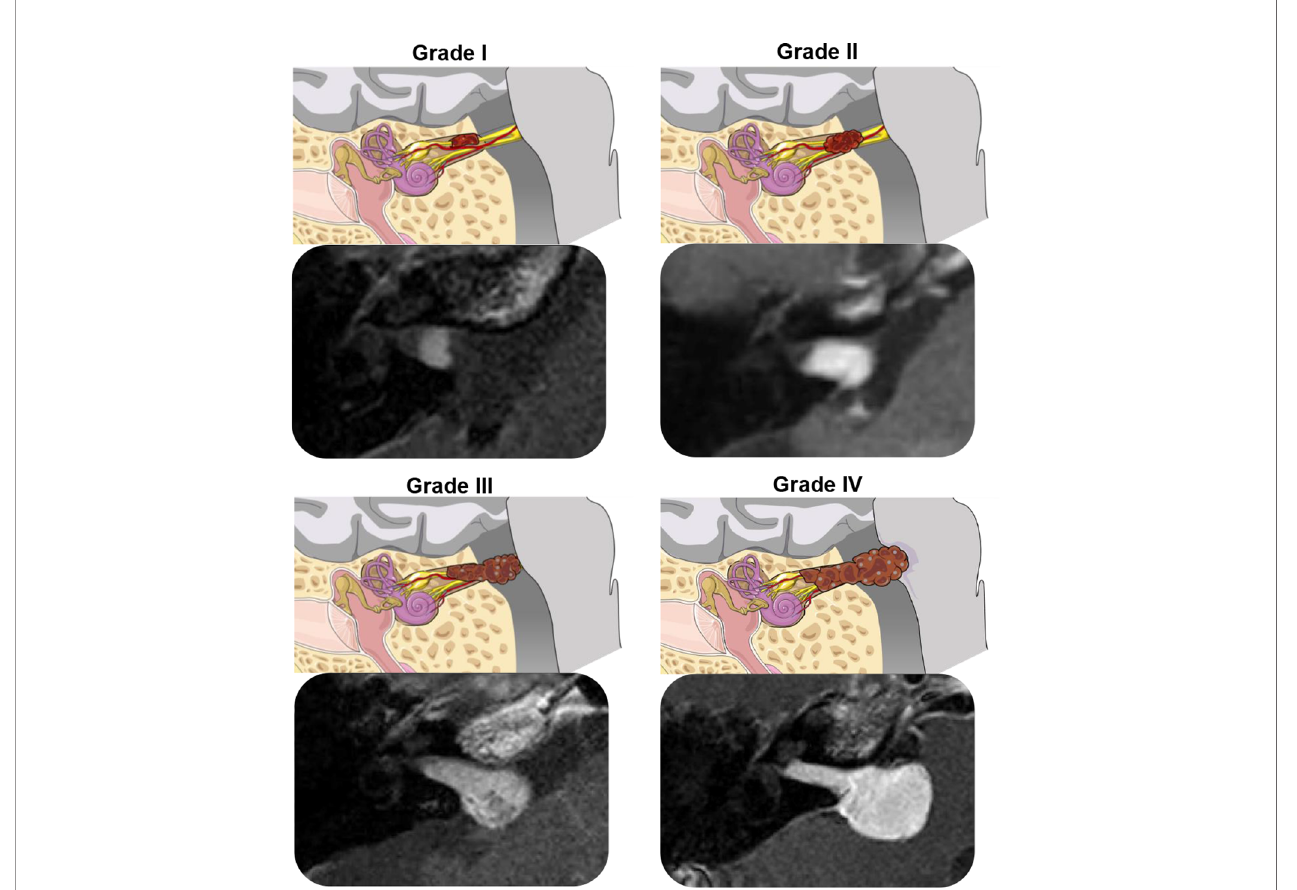
FIGURE 1 | Illustrations and T1-weighted post-gadolinium MRI scans demonstrating the Koos Grading System for vestibular schwannoma (20). Grade I, small intracanalicular tumor; Grade II, small intracanalicular tumor with protrusion into the cerebellopontine angle; Grade III, tumor occupying the cerebellopontine cistern, touching but not compressing the brainstem; Grade IV, large tumor with brainstem compression. The illustrations were modi fi ed from SMART (Servier Medical Art), licensed under a Creative Common Attribution 3.0 Generic License